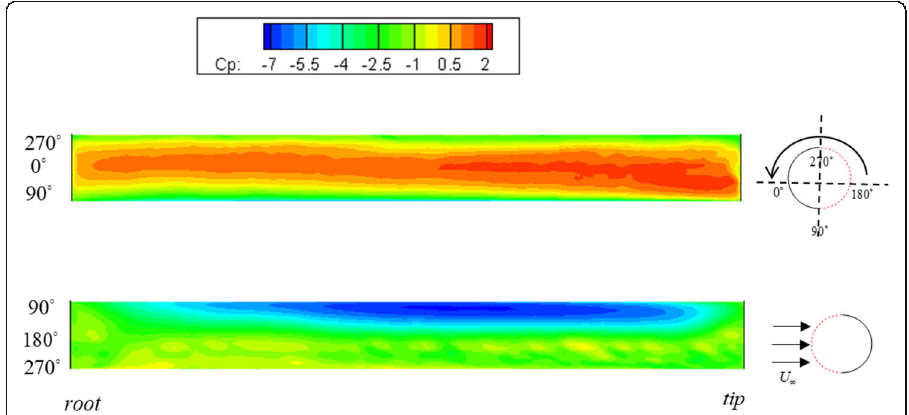
Fig. 5 Contours of dimensionless pressure coefficient on the Magnus blade for AR = 10. The projected surface is denoted by the black solid line